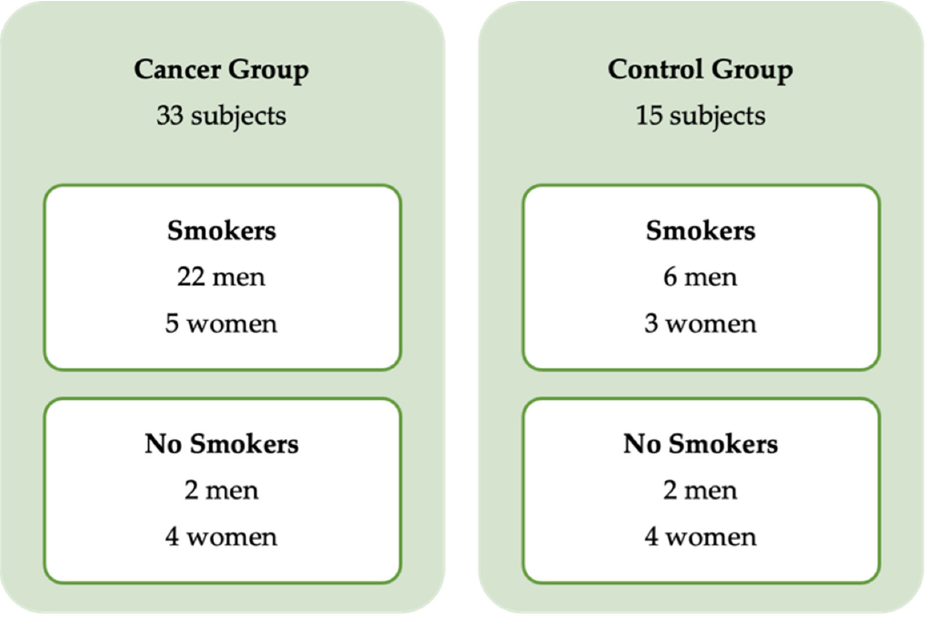
Figure 1. Sample diagram. Table 1. Demographic data of the sample.